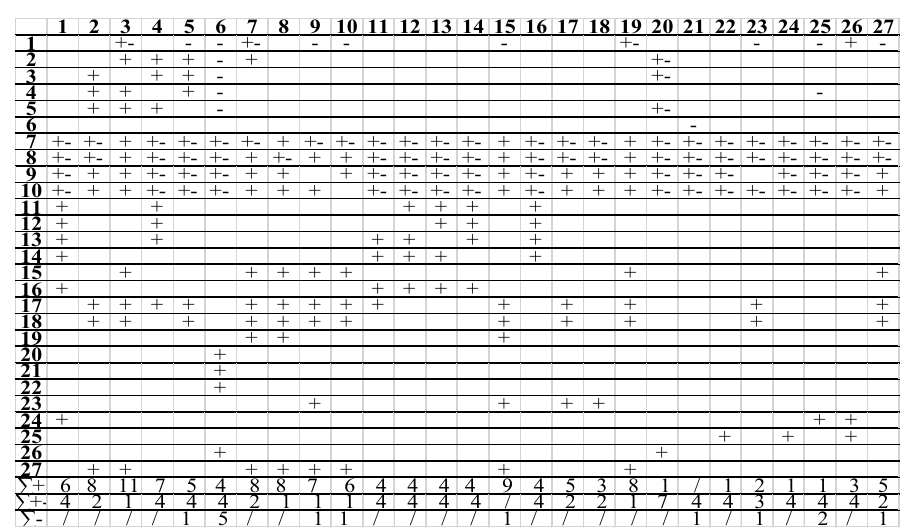
Picture 1: Sociometric matrix